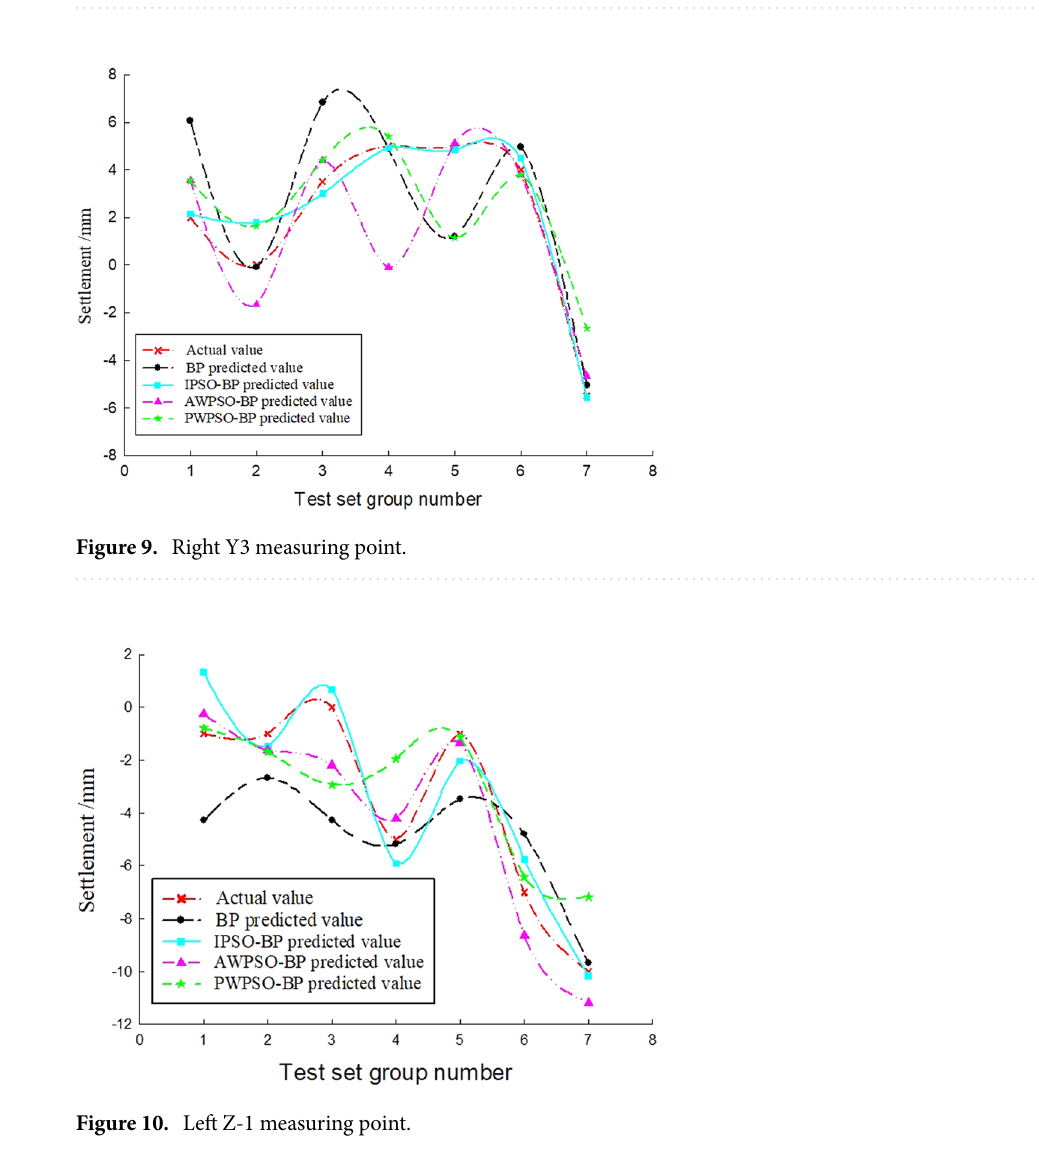
Figure 8. Right Y2 measuring point.